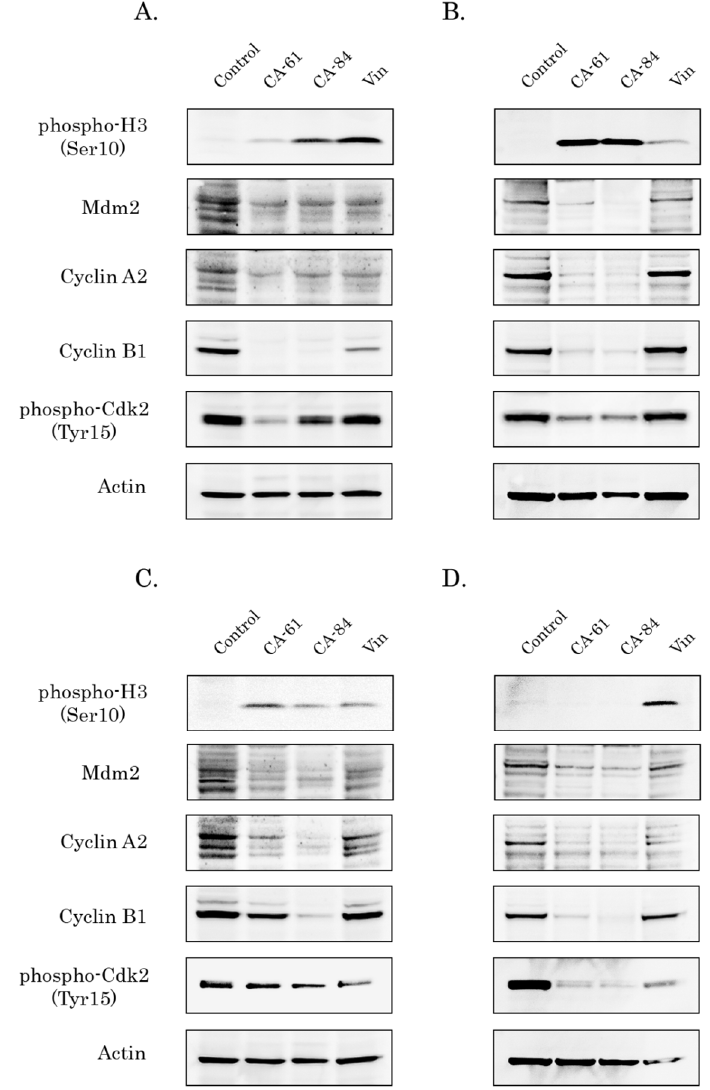
Figure 11. CA-61 and -84 dysregulate the expression of cell regulatory proteins in cancer cell lines. Immunoblot analysis for cyclins A2 and B1, Mdm2, phospho-Cdk2 (Tyr15), and phospho-H3 (Ser10) in HCC1806 breast cancer ( А ), MDA-MB-231 breast cancer ( B ), H1299 lung cancer ( C ), and PC-3 prostate cancer ( D ) cells after treatment with DMSO (negative control), CA-61, CA-84 (10 μ M), and Vinblastine (Vin) (0.01 μ M) for 48 h. Actin stain is used as a loading control.